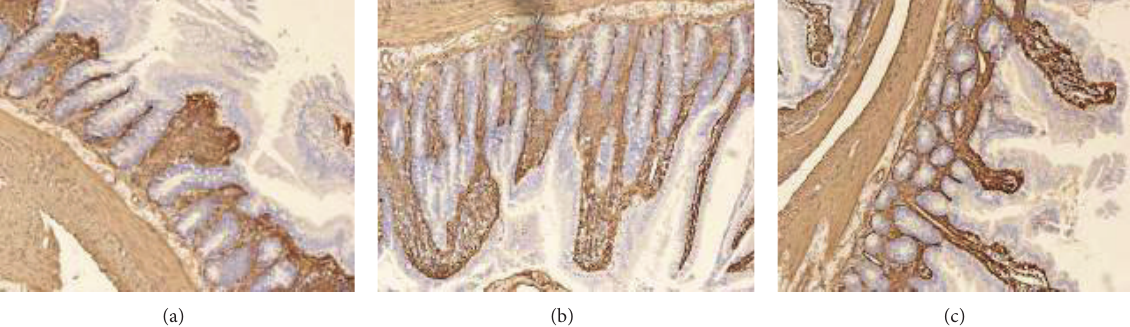
Figure 7: Lamininhybridization in situ . Mucosal laminin mRNA is expressed in the basal part of the intestinal mucosa. A representative samplefromtheSBTgroup( 𝑛 = 12 ):mucosallamininmRNAexpressionislowwithsectionsofaninterruptedexpression.(b)Arepresentative sample from the pre-SNP group ( 𝑛 = 14 ): the expression is continuous. (c) Post-SNP group ( 𝑛 = 16 ): the expression is low and there are interruptions present ( ×